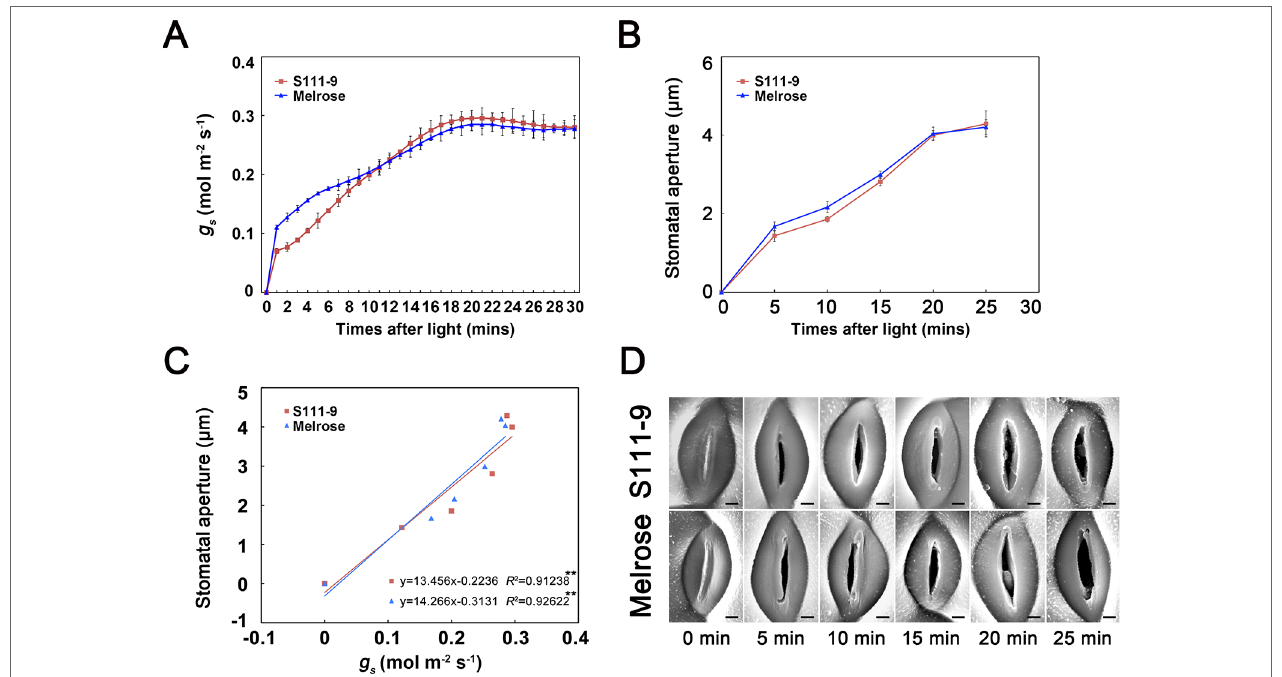
FIGURE 3 | Application of the plant surface impression technique (PSIT) to study the dynamic variation in stomatal aperture and the correlation between stomatal conductance and stomatal aperture after light illumination. The third fully expanded leaves of 25-day-old Melrose and S111-9 under no salt stress for 0, 5, 10, 15, 20, and 25 min were used in this experiment. (A) Changes in stomatal conductance (g s ) after light illumination. The measurement method for g s was the same as described in Figure 2 . (B) Changes in stomatal aperture after light illumination. The determination of stomatal aperture was described in Figure 2 . (C) Correlation analysis between g s and stomatal aperture. The analysis data were obtained from (A , B) . (D) Changes in stomatal aperture in both soybean varieties (S111-9 and Melrose) by plant surface impression technique. All sections were observed under SEM at 1,500× magnification. Scale bar = 3 μm. Three biological replicates were completed in this experiment. ** - extremely significant difference ( P <